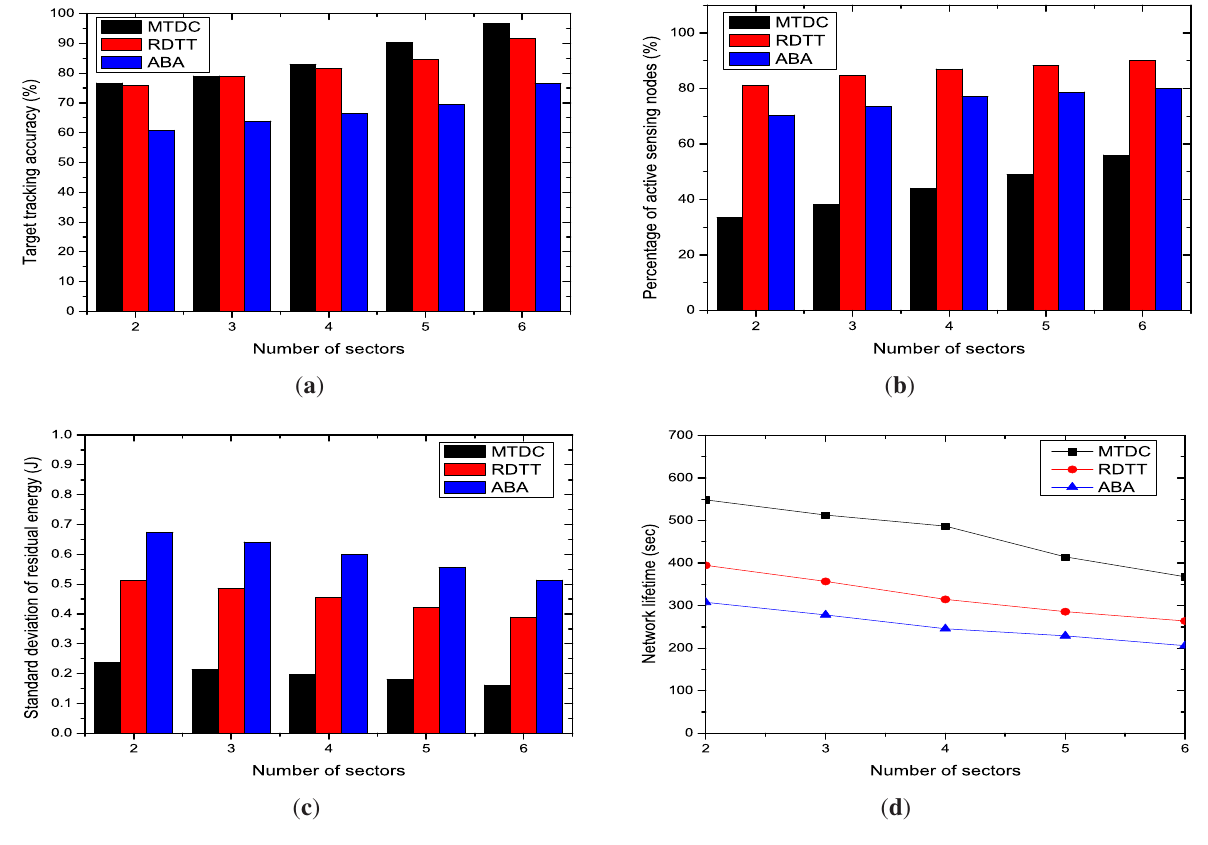
Figure 9. Impacts of the number of sectors. ( a ) Target tracking accuracy; ( b ) percentage of active sensing nodes; ( c ) standard deviation of the residual energy; ( d ) network